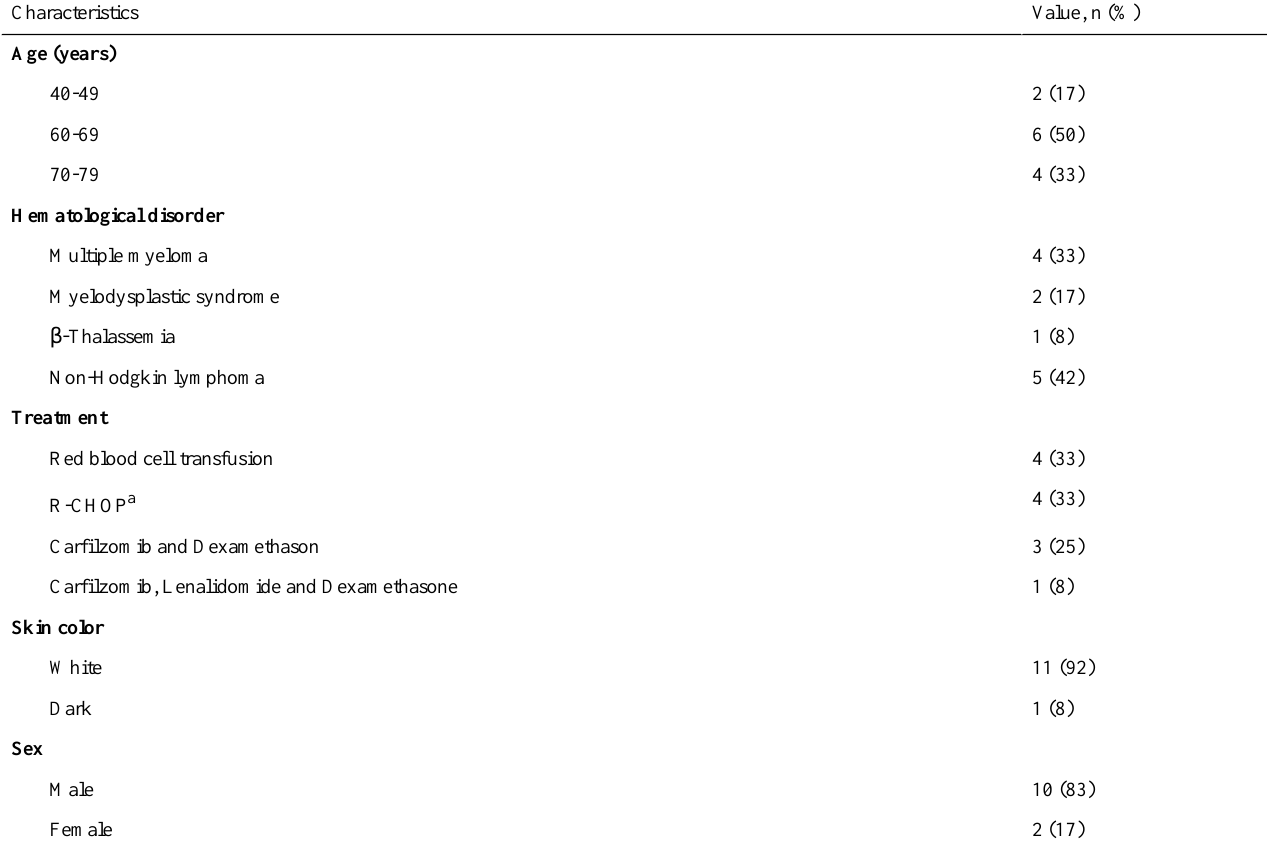
Table 1. Baseline